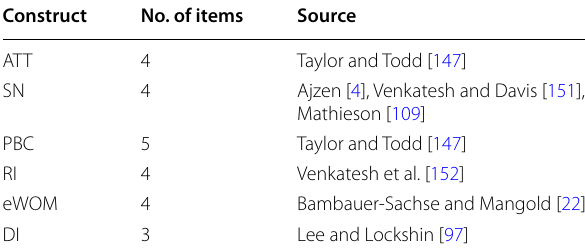
Table 1 Items used in the questionnaire. Source : The Authors